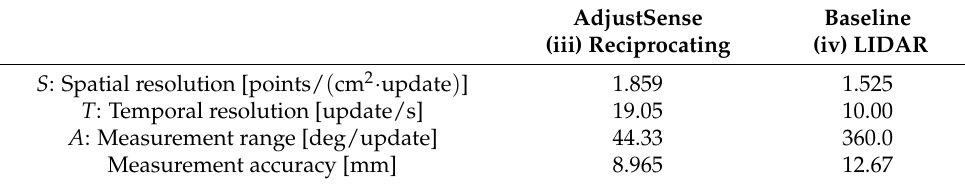
Table 3. Spatio-temporal resolution, measurement range, and measurement accuracy in reciprocating mode of AdjustSense and LIDAR calculated with 3D point obtained from moving plastic